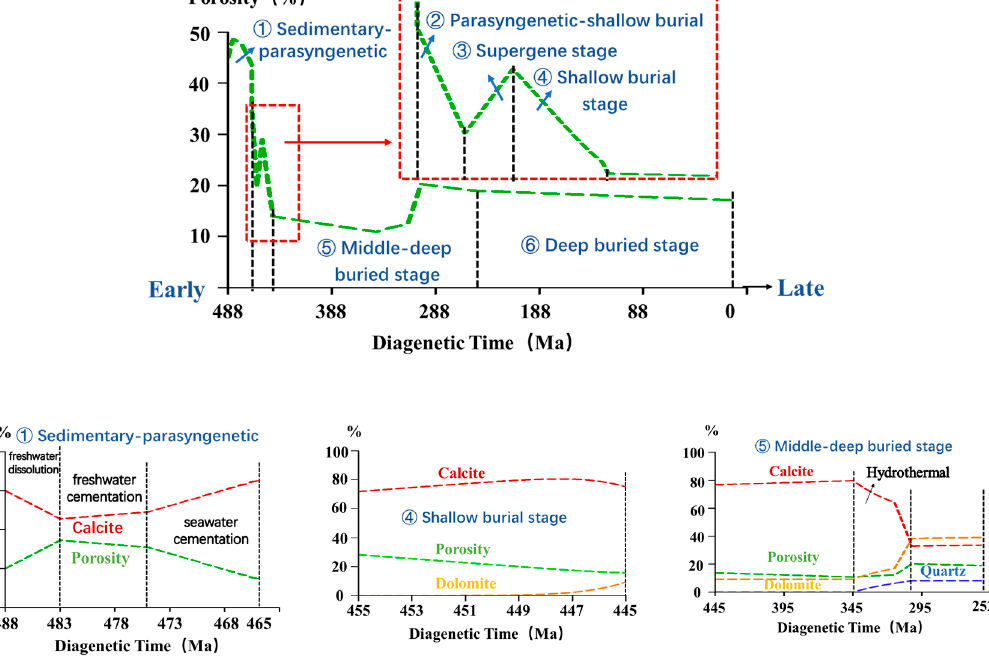
Figure 10. Porosity and typical mineral content evolution under seawater evaporation environment.